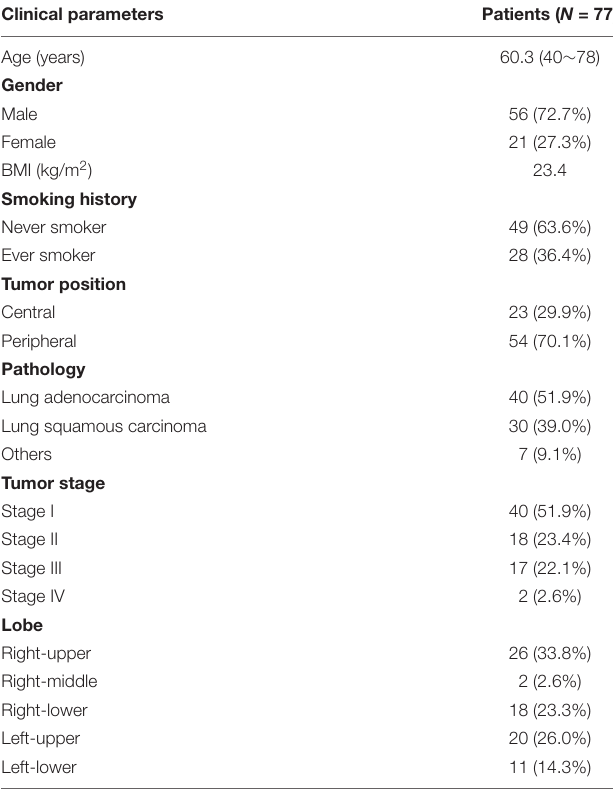
TABLE 1 | The clinical characteristics of patients. Clinical